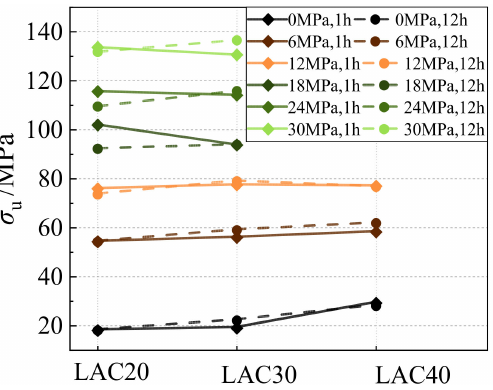
Figure 7. Relationship between concrete strength grade and peak